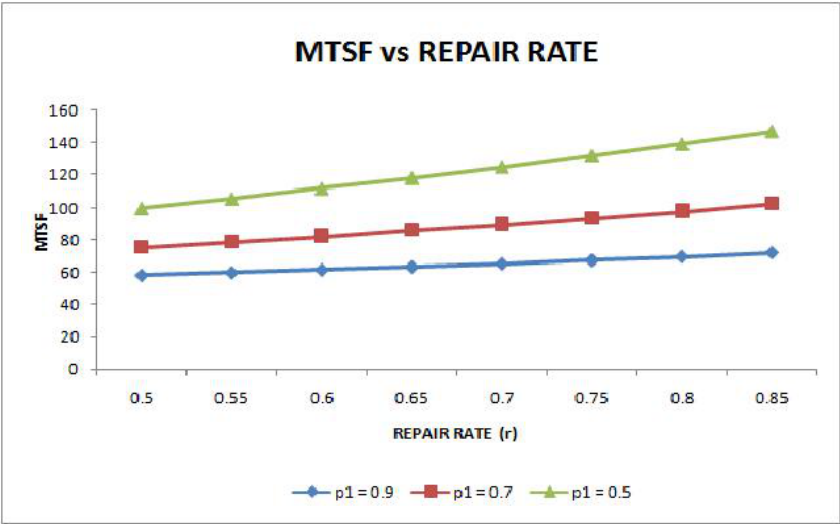
Fig. 4. MTSF vs repair rate